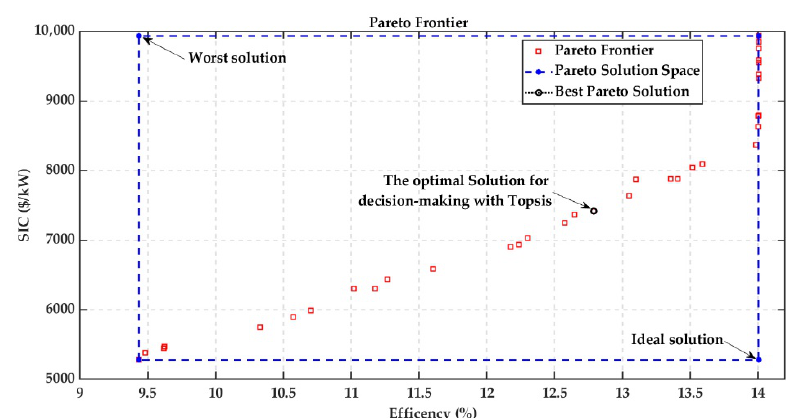
Figure 10. The selection of the optimal solutions in the Pareto frontier.